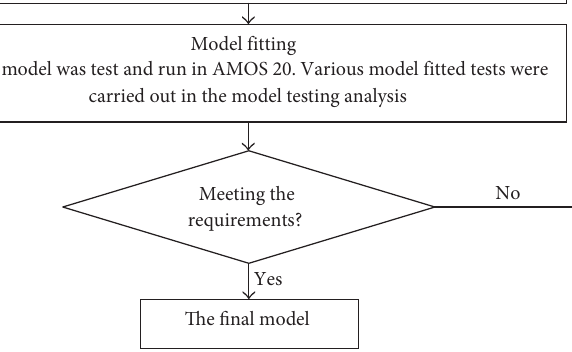
Figure 7: Framework showing the process of the development of SEM for riding behaviour before curve entry.